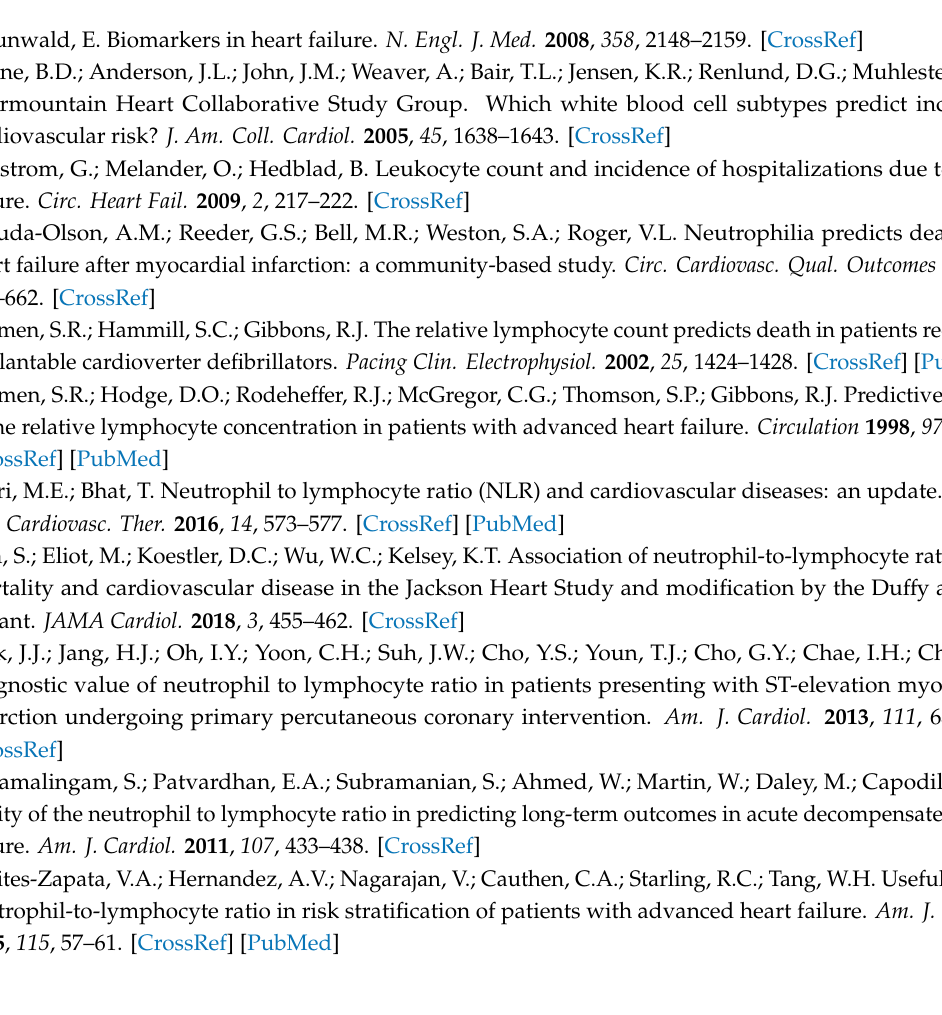
Figure S1: Overall in-hospital mortality and post discharge 3-year mortality in HF patients subgroup analysis by de novo HF versus worsening of pre-existing HF, Figure S2: Overall in-hospital mortality and post discharge 3-year mortality in HF patients subgroup analysis by LVEF categories, Table S1: In-hospital clinical outcomes stratified by quartiles of neutrophil to lymphocyte ratio at admission, Table S2: Univariate and multivariate logistic regression analyses for all-cause in-hospital and post discharge 3-years mortality in HF Patients subgroup analysis by de novo HF versus worsening of pre-existing HF., Table S3: Univariate and multivariate logistic regression analyses for all-cause in-hospital and post discharge 3-years mortality in HF Patients subgroup analysis by LVEF categories., Table S4: In-hospital clinical outcomes of HF patients whose aggravating factor were not infection or ischemia stratified by quartiles of neutrophil to lymphocyte ratio at admission, Table S5: In-hospital clinical outcomes of HF patients whose aggravating factor were infection or ischemia stratified by quartiles of neutrophil to lymphocyte ratio at admission. Table S6: Univariate and multivariate logistic regression analyses for all-cause in-hospital and Cox regression analysis for post discharge 3-years mortality in HF Patients stratified by quartiles of neutrophil to lymphocyte ratio at admission. Table S7: Univariate and multivariate logistic regression analyses for all-cause in-hospital and post discharge 3-year mortality in HF Patients subgroup analysis by aggravating